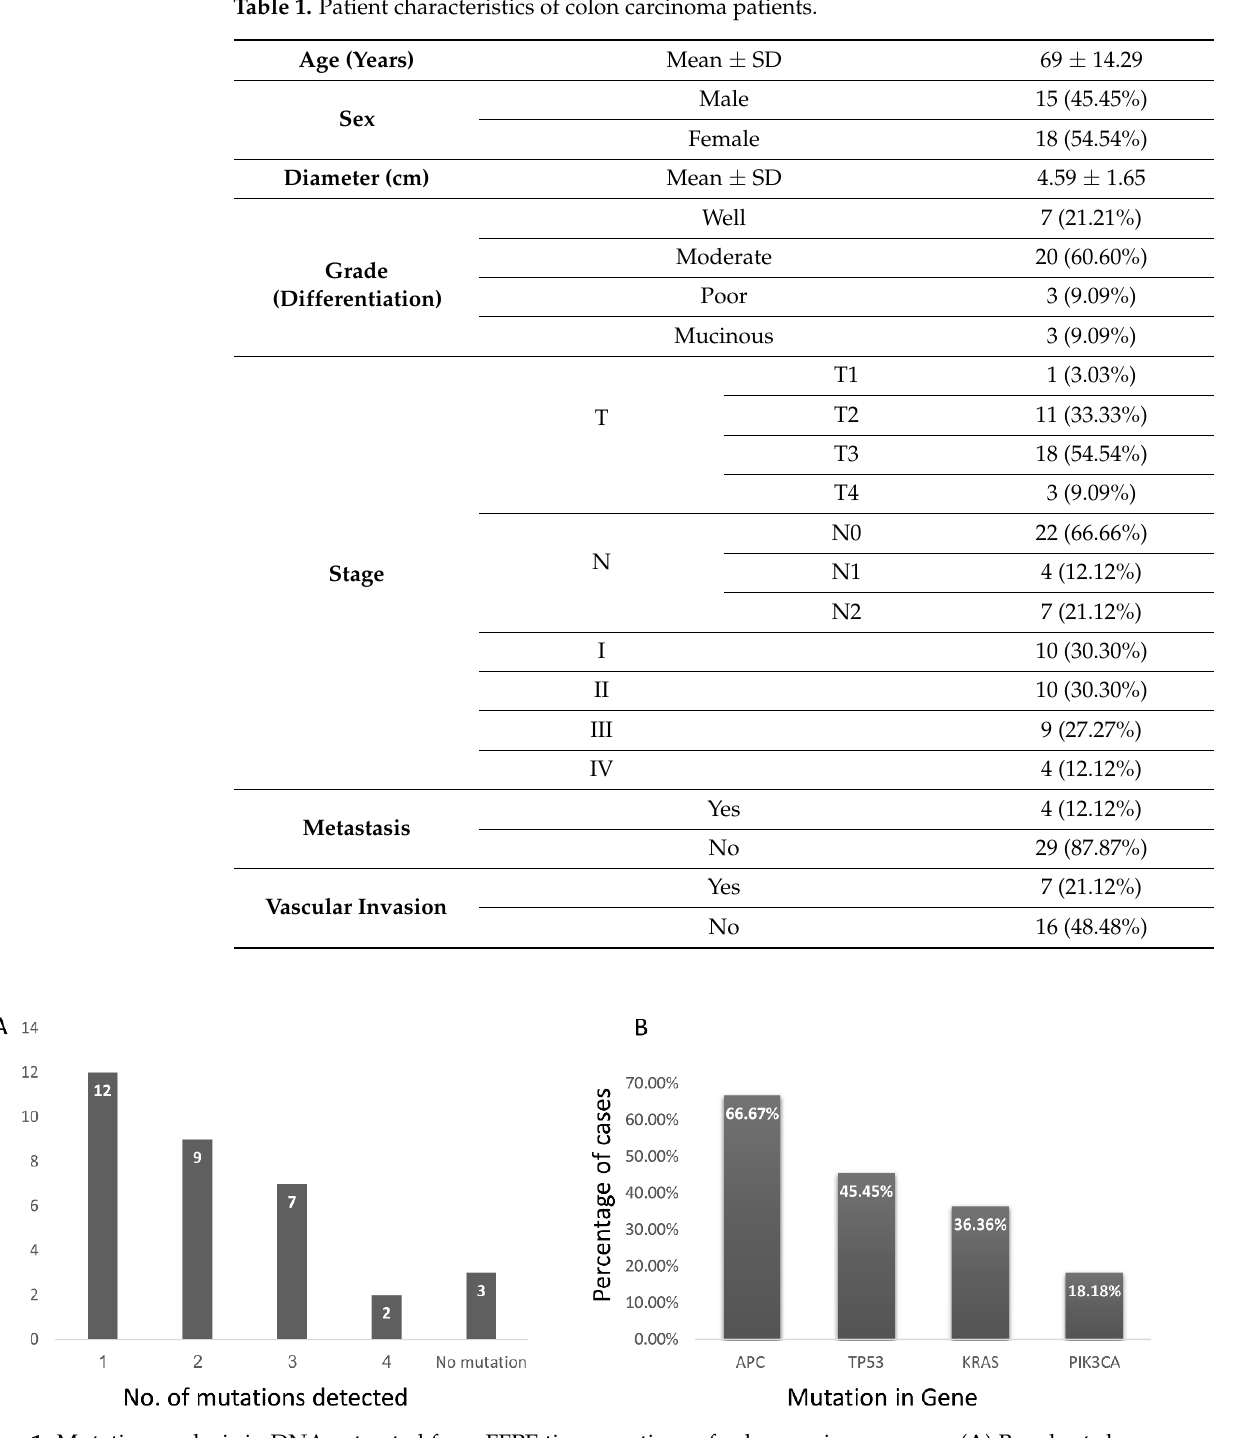
Figure 1. Mutation analysis in DNA extracted from FFPE tissue sections of colon carcinoma cases. ( A ) Bar chart shows number of mutations detected in cases of colon carcinoma using 19 amplicon gene panel. One mutation was detected in 12/33 cases, 2 in 9/33, 3 in 7/33, 4 in 2/33 and no mutation was detected in 3/33 cases of colon carcinoma. ( B ) Bar chart shows the prevalence of mutation in various genes in cases of colon carcinoma. The most common mutated gene was APC, present in 66.67% of cases followed by TP53 in 45.45%, KRAS in 36.36% and PIK3CA in 18.18%.